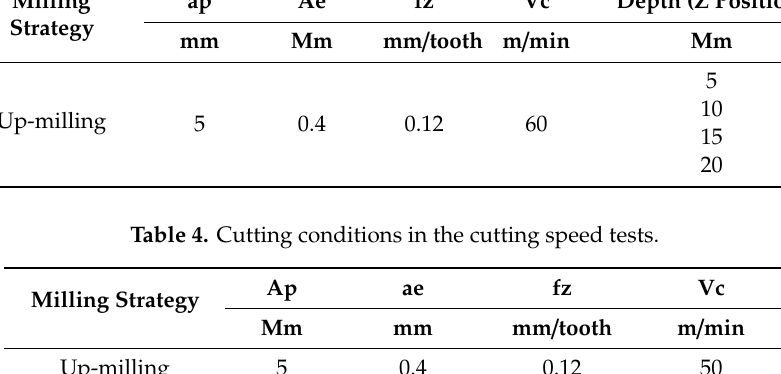
Figure 4. Tool path strategies for the face milling in different strategies ( a ) Up milling; ( b ) Down milling; ( c ) Slot milling.